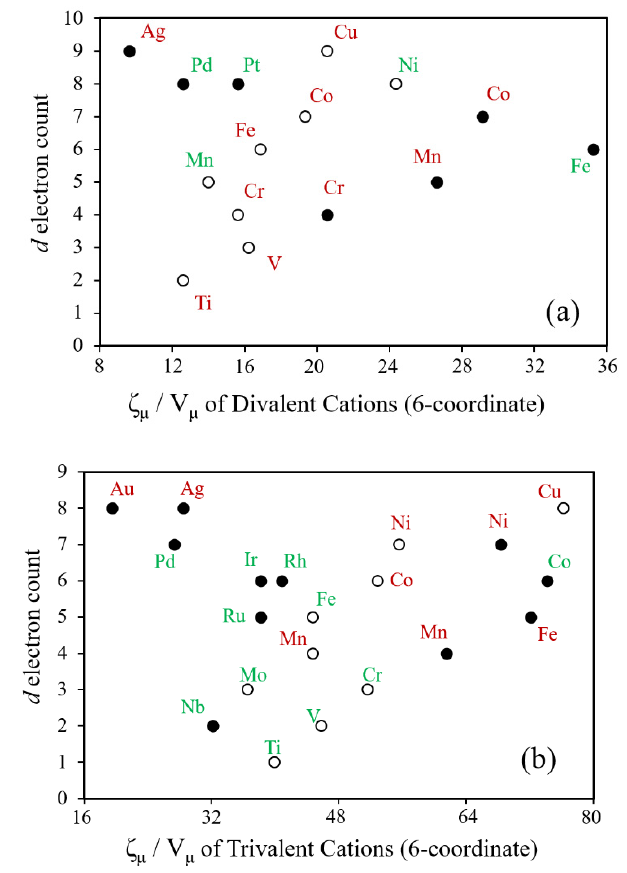
Figure 23. Plots of the d-electron count versus ζ µ / V µ for ( a ) divalent and ( b ) trivalent TM cations in an octahedral coordination environment, where the low-spin and high-spin cations are represented by shaded and unshaded circles, respectively. The elements in red are susceptible to a Jahn–Teller distortion or may show uniaxial magnetism.